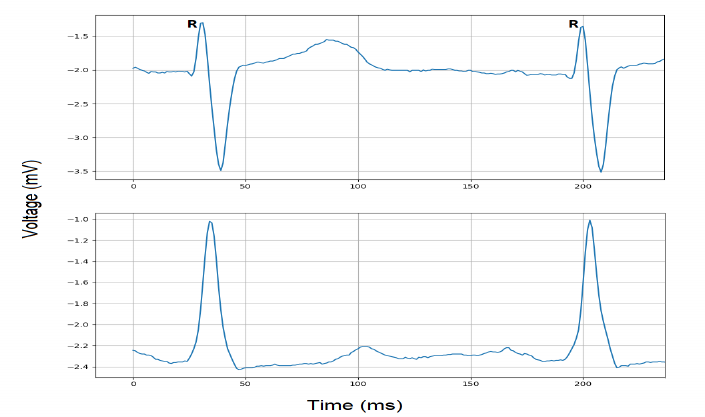
Figure 4. ECG signals within R-R interval extracted from Lead 3 ( top ) and Lead 5 ( bottom